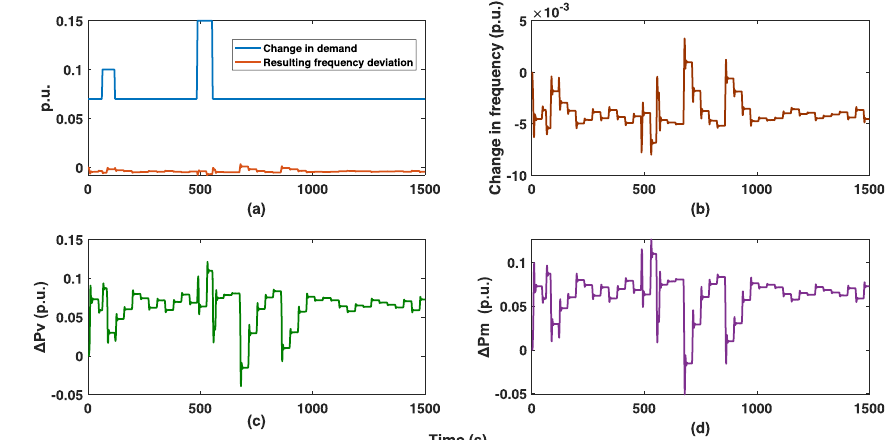
Fig. 8 System response during changes in demand with frequency measurement noise variance of 0.01. a Variation in Δ f,; b frequency response during control action; c Variation of states Δ P v ; d Variation of states Δ P